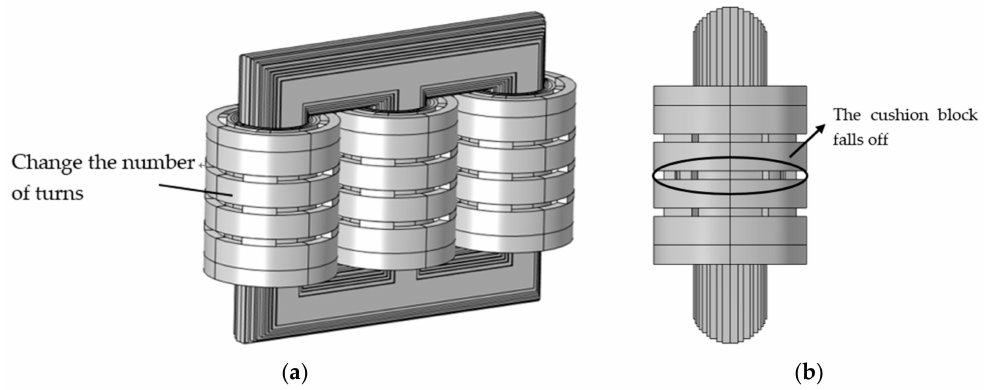
Figure 6. Winding insulation fault model. ( a ) Change the number of turns to simulate insulation; the ( b ) simulated insulation when the cushion block falls